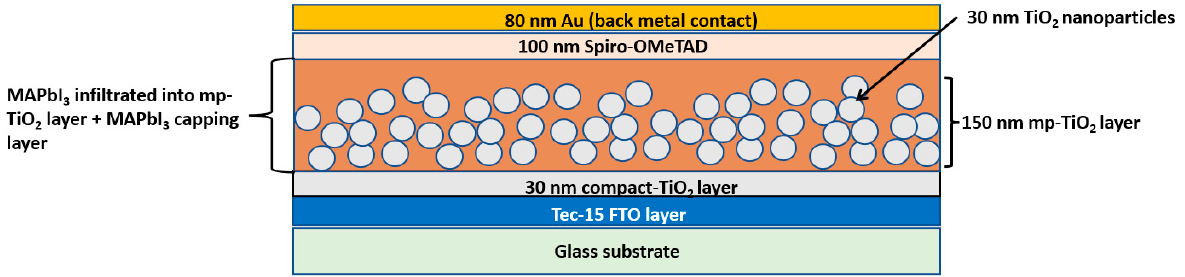
Figure 1. The typical device structure and the layer thicknesses used in this